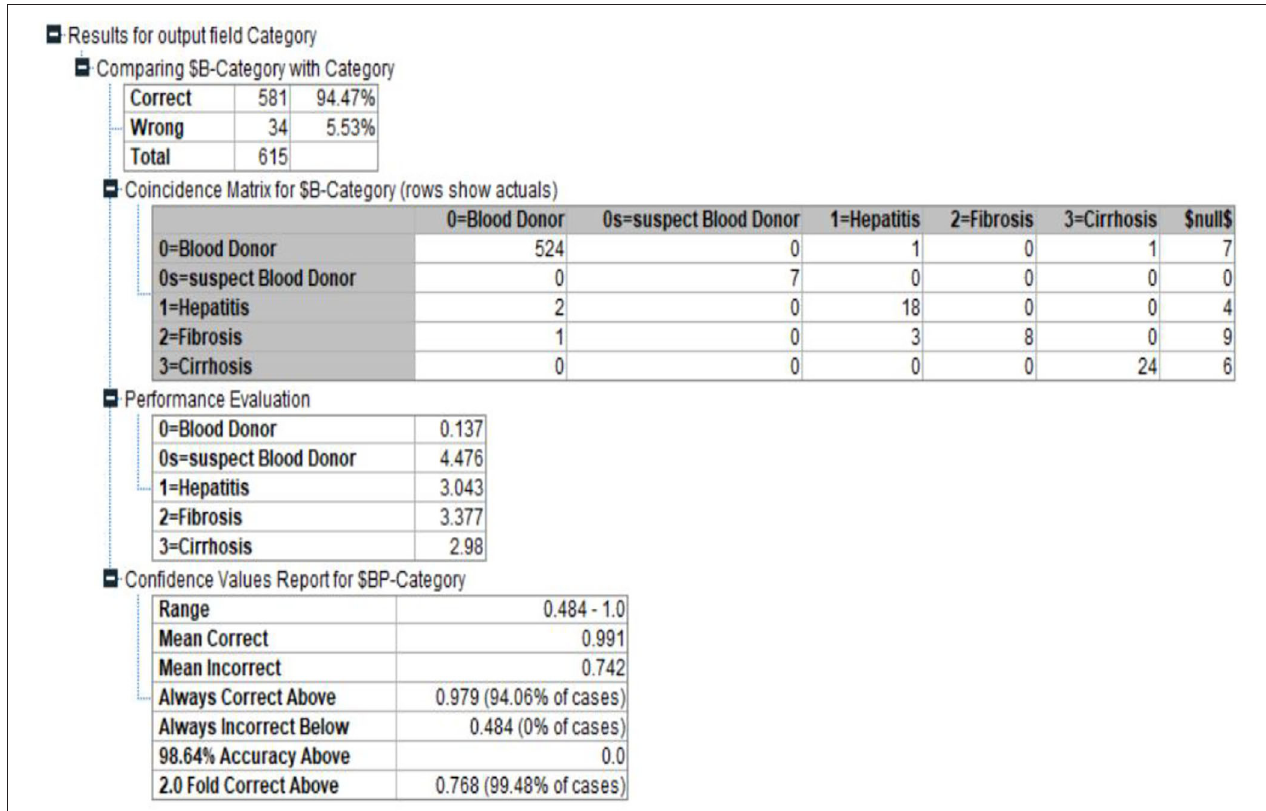
FIGURE 6 | Bayesian network Classification for